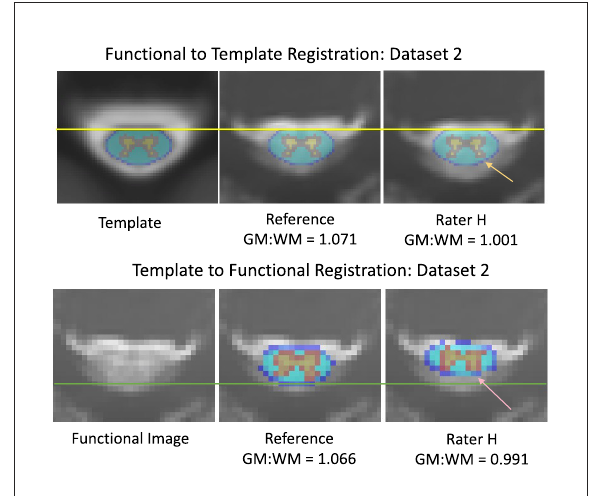
FIGURE3 Differences in alignment between registration informed by reference and rater H masks, from dataset 2. The mean DSC was 0.736 across the axial slices for the input masks between the reference and rater for dataset 2 (Top) Registration of functional images to the PAM50 template. The yellow line represents the most anterior white matter voxel coordinate of the template mask. The orange arrow indicates an area of gray matter in the dorsal horn that is not aligned with the template mask in a registration informed by Rater H masking (Bottom) Registration of the PAM50 template atlas to functional image space. The green line represents an estimate of the most dorsal coordinate of the functional image. The pink arrow indicates an area of gray matter in the dorsal horn that is not aligned with the atlas in Rater H registration. Accuracy of registration alignment was supported by the GM:WM ratio, as misalignment introduces a mixing of GM, WM, and potentially CSF voxels into the masked areas, reducing the observed